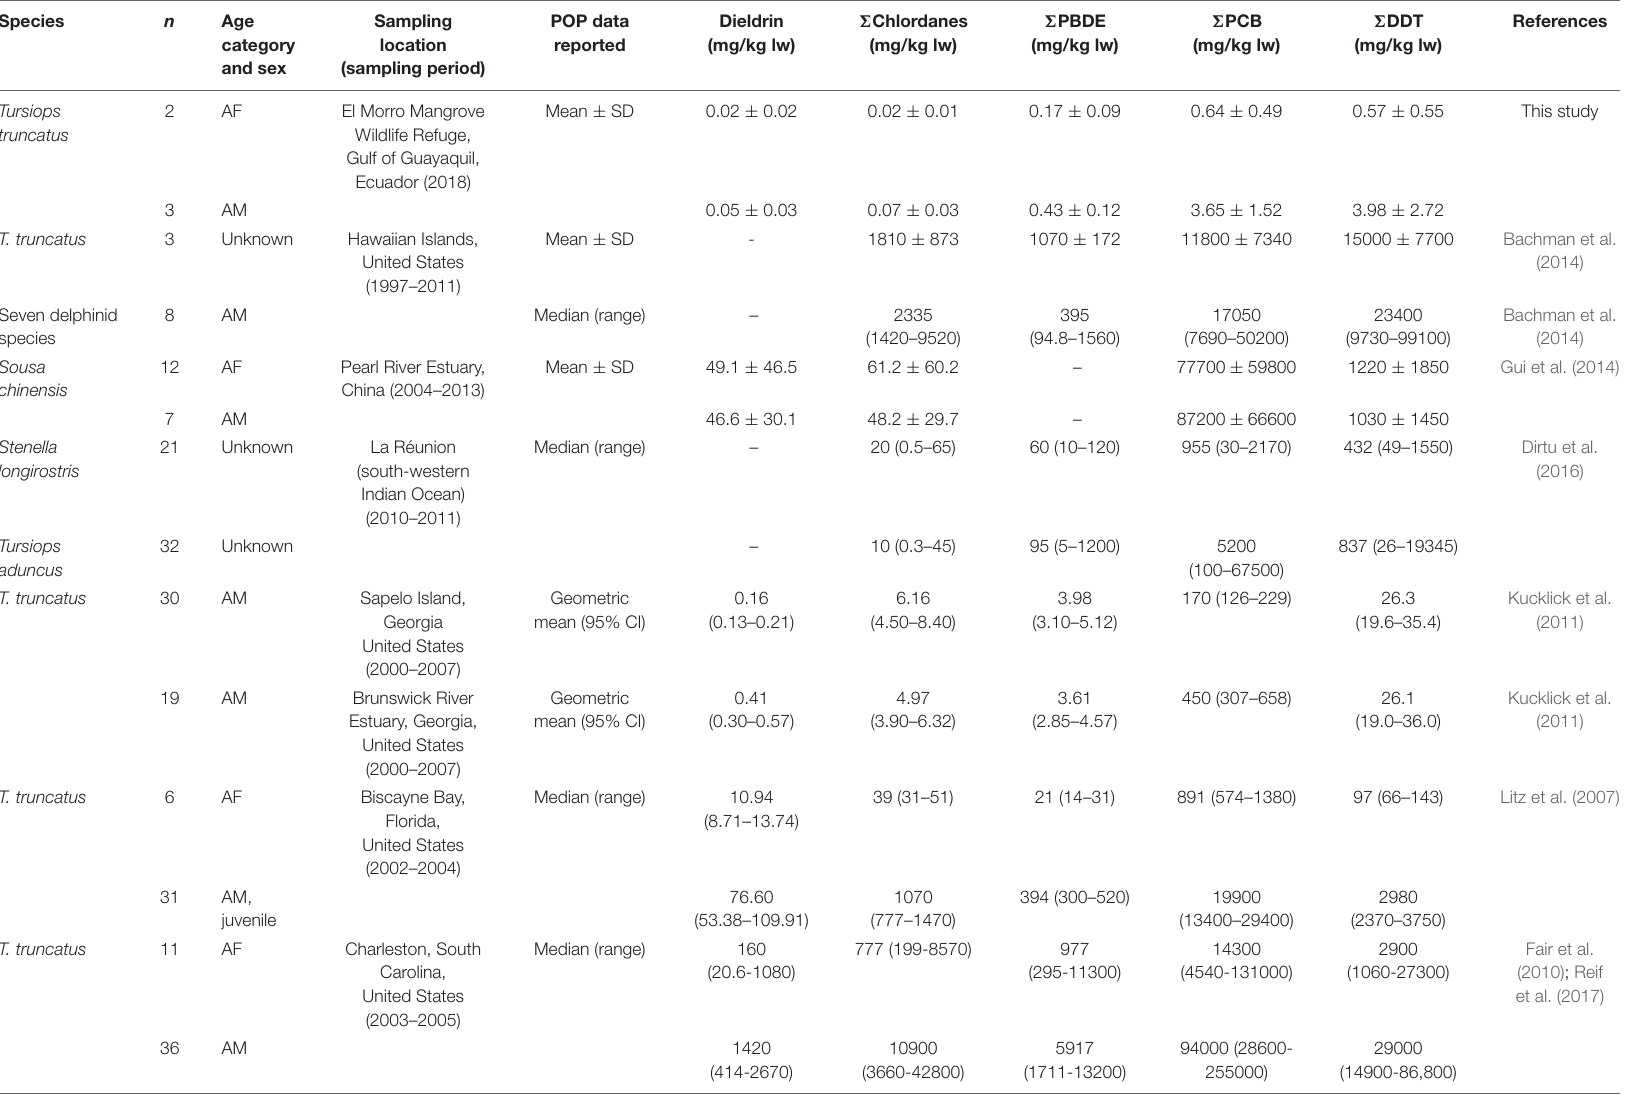
TABLE 3 | Geographical comparisons between persistent organic pollutant data reported in the existing literature and the data of this study in the blubber of delphinid species from different locations (Pacific Ocean, Gulf of Mexico, Indian Ocean and North Atlantic Ocean).